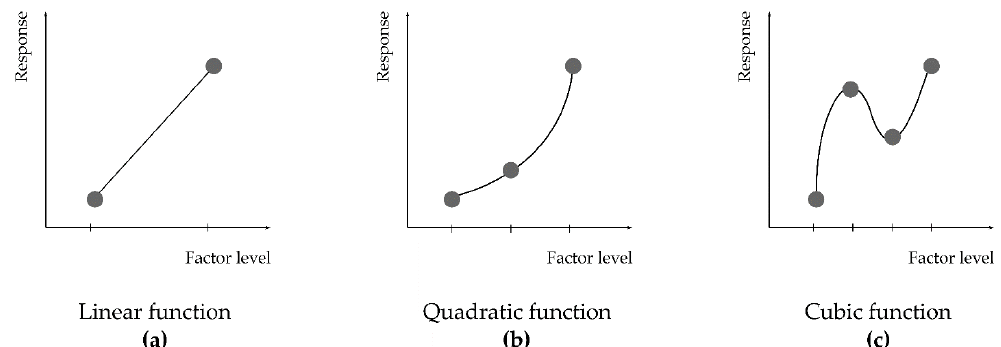
Figure 5. Graphical representation of the possible response function and the number of levels required for its estimation. Two-level factorial designs presuppose a linear response ( a ), while the inclusion of intermediate points permits one to calculate the possible curvature in the response ( b , c ).